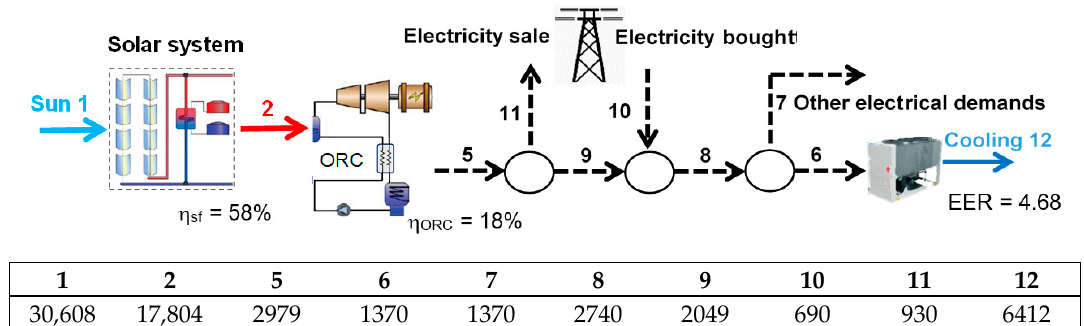
Figure 14. Annual energy balance of the solar parabolic trough–ORC analyzed plant (system B), MWh/year.